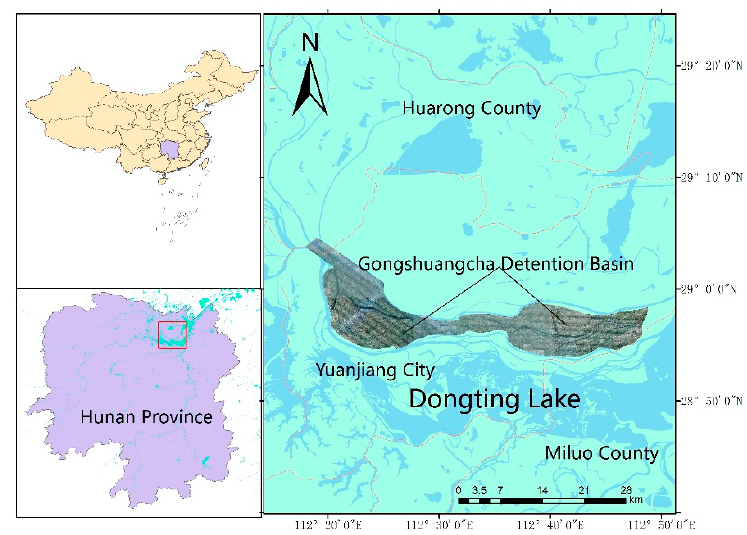
Figure 1. Location of the Gongshuangcha detention basin in the Dongting Lake area.